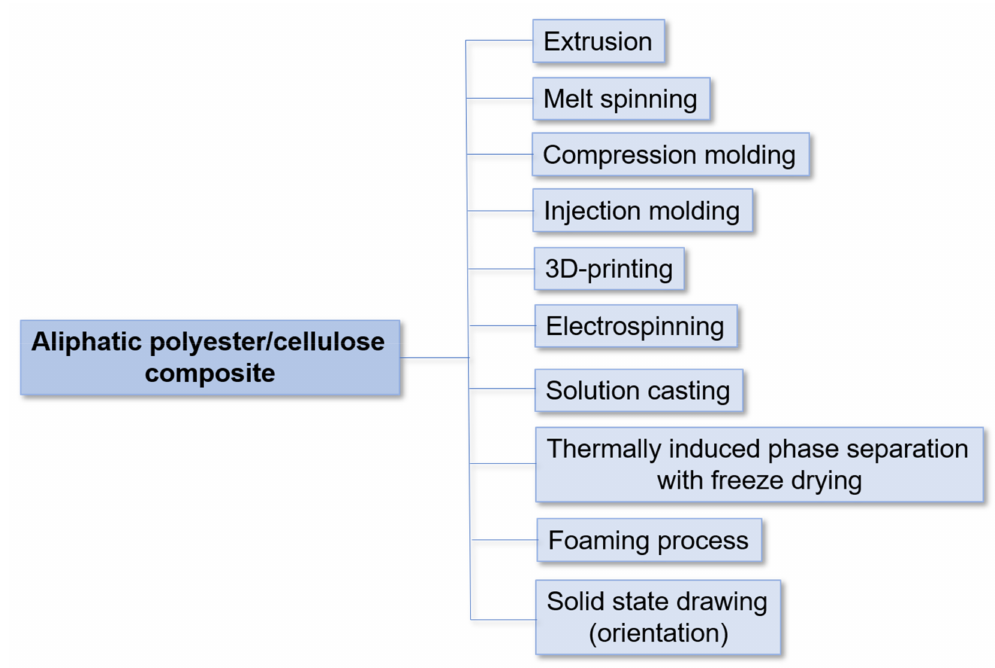
Figure 15. Scheme for different techniques of composite